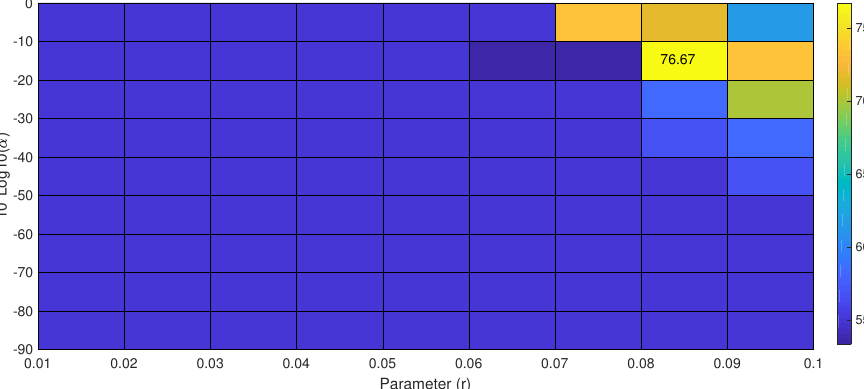
( α ) of the proposed approach 10